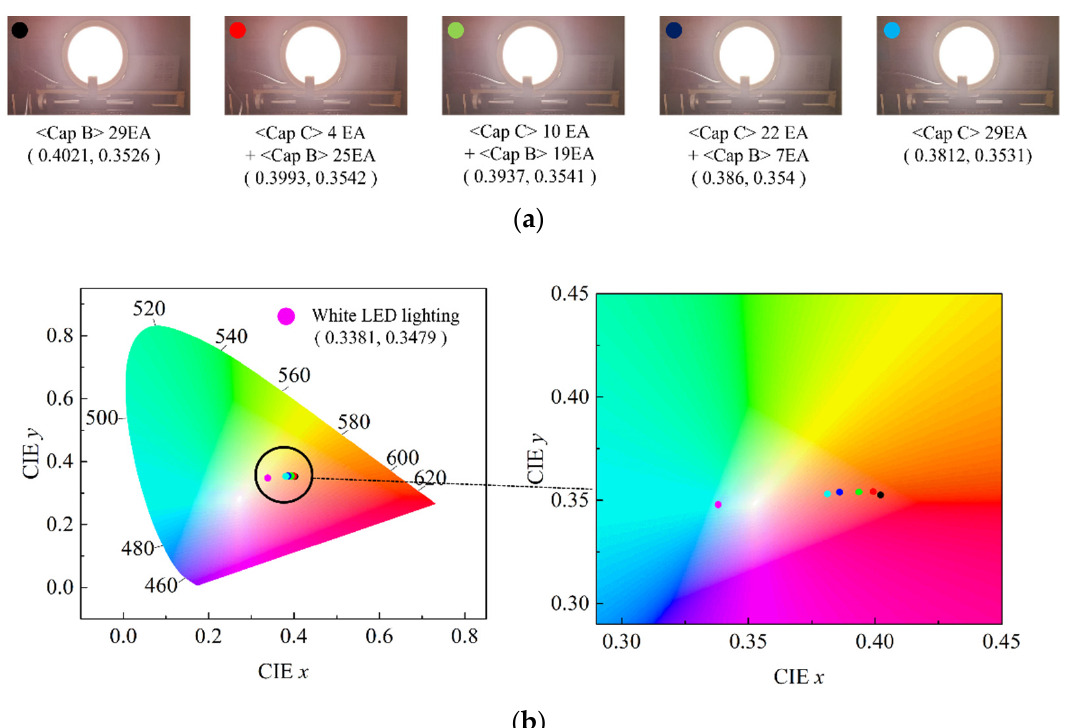
Figure 12. The change in the color shade of the white LED lighting depending on the QD cap con- figuration ( a ) and the change in the color coordinates on the chromaticity diagram ( b ). The red point in ( b ) denotes the original color coordinates with no QD caps being adopted.